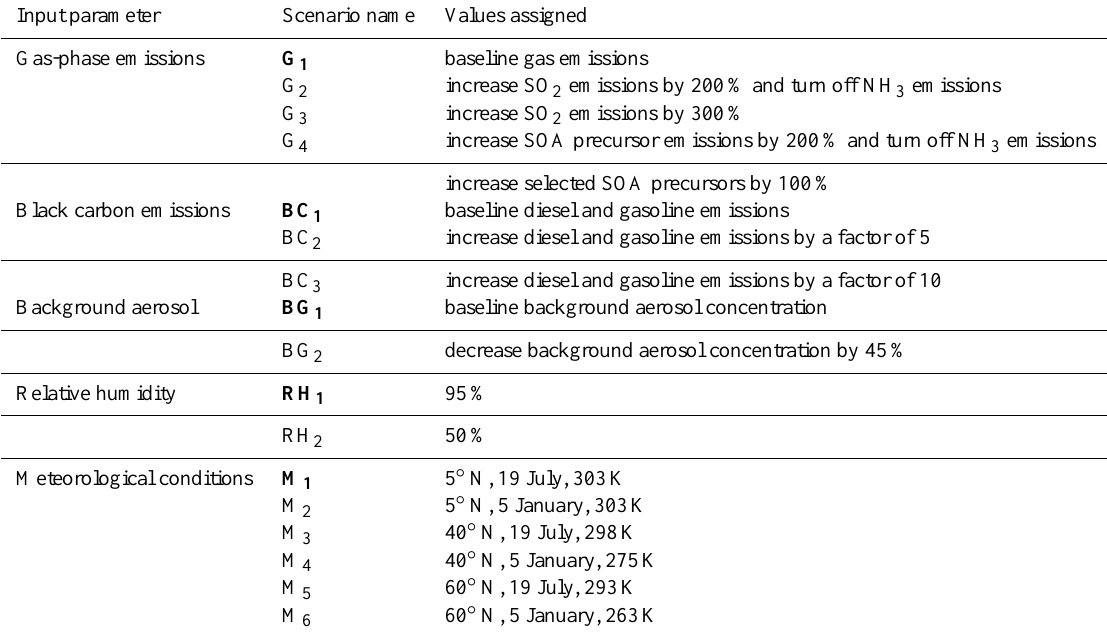
Table 4. Input parameters varied in the ensemble of sensitivity simulations. Scenarios corresponding to the baseline conditions are indicated in bold. All combinations of scenarios were included in the full ensemble of 288